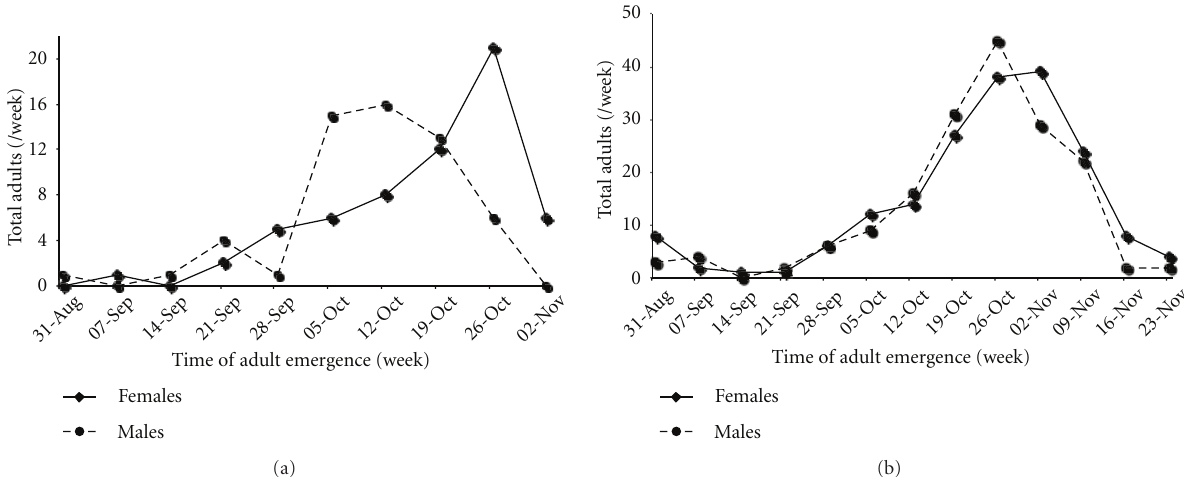
Figure 3: Weekly total number of female (solid line) and male (broken line) adults emerging from aestivation in fall 2003 (a) and 2004 (b). Note di ff erence in scale: 2003 from 238 pupae sexed; 2004 from 933 pupae sexed.